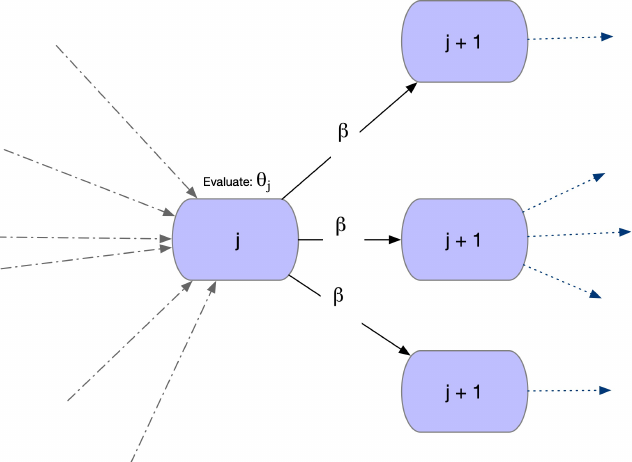
Figure 4. Node walk evaluation at node j